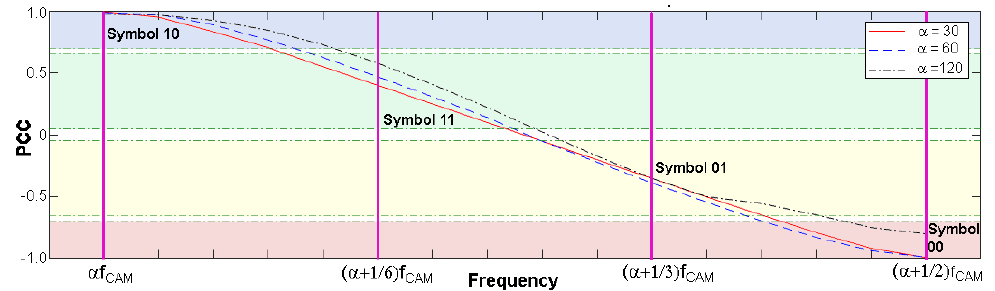
Figure 10. Relation between the PCC values and the switching frequencies. All the experiments were performed with a camera’s frame rate of 30 fps. The straight red line represents α = 30, and band’s size = 36 pixels. The dashed blue line represents α = 60, and band’s size = 18 pixels. The dotted black line represents α = 120, and band’s size = 9